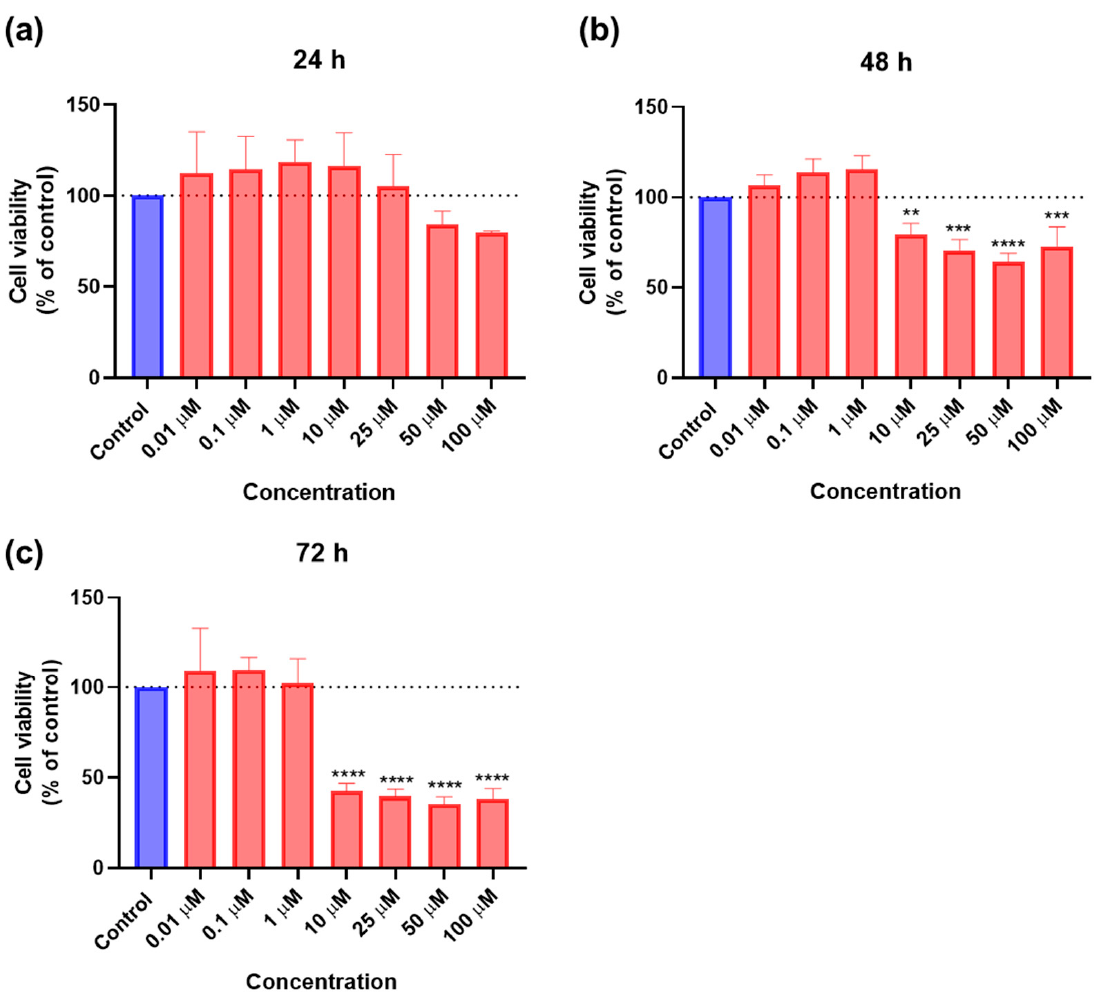
Figure 11. Cytotoxic results of A549 after exposure to increasing concentrations of 5-FU (0.01–100 µ M) for 24 h ( a ), 48 h ( b ), and 72 h ( c ). Control cells were treated with 0.01% DMSO (vehicle). Cell viability was obtained using the MTT assay and the results are given as the mean ± SEM ( n = 3). ** Statistically significant vs. control (vehicle) at p < 0.01; *** statistically significant vs. control (vehicle) at p < 0.001; **** statistically significant vs. control (vehicle) at p < 0.0001.